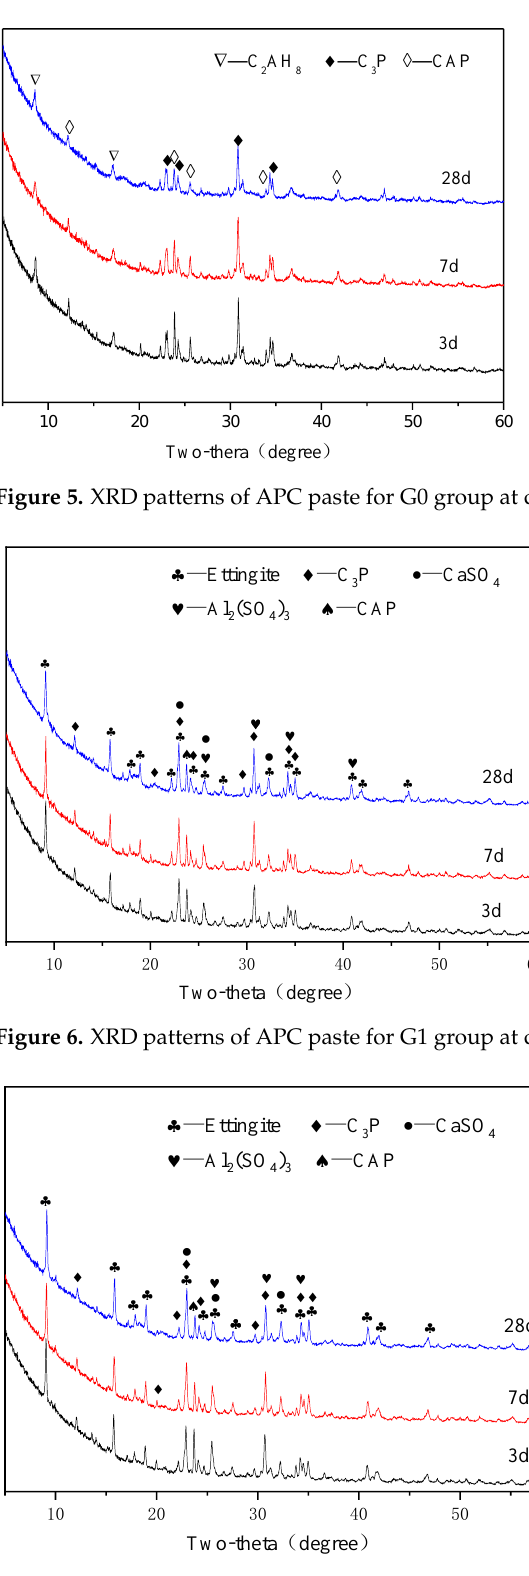
Figure 7. XRD patterns of APC paste for G2 group at different ages.